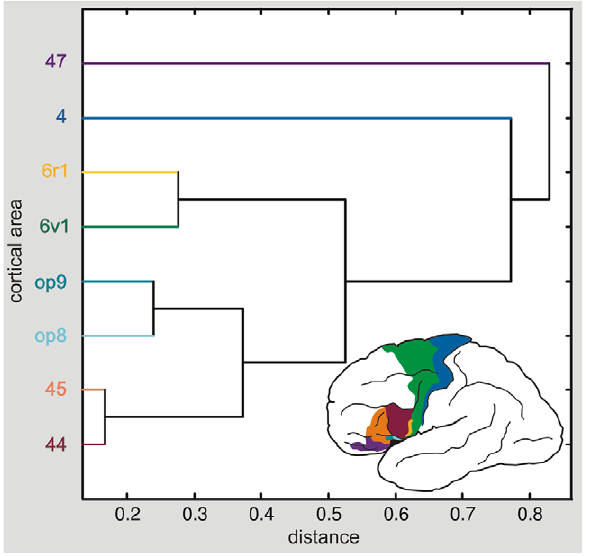
Figure 10. Hierarchical cluster analysis of the posterior inferior-frontal areas based on quantitative receptor architec- tonic data. Euclidean distances were calculated as a multivariate measure for interareal differences. A small Euclidean distance between areas, e.g., between areas 44 and 45 or areas op8 and op9 , indicates a high similarity in their receptor architectonic organization. The graph shows that areas 47 and 4 differ maximally from the group of areas. Areas 44 and 45 were not divided in 44d and 44v , or 45a and 45p , because all these areas were not present in all brains studied here.